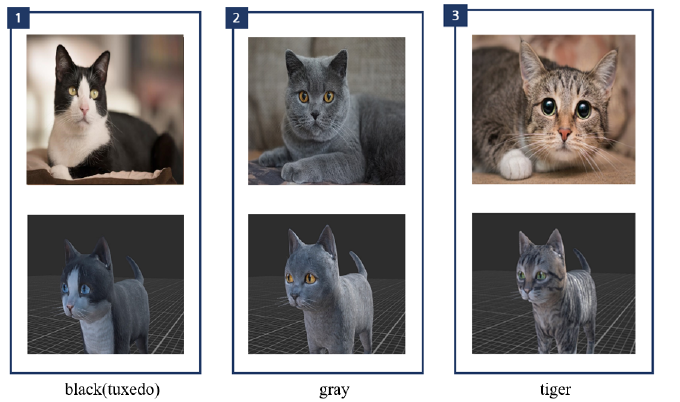
Figure 5. Experimental procedure.